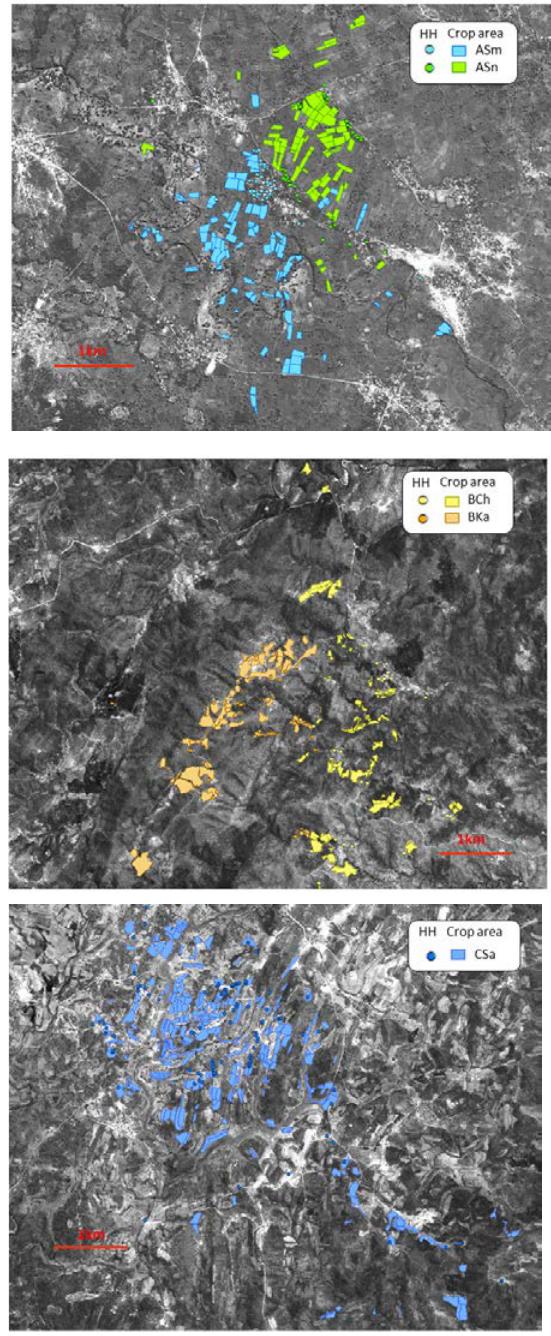
Fig. 3 Crop Field Distribution in site A (upper), site B (middle) and site C